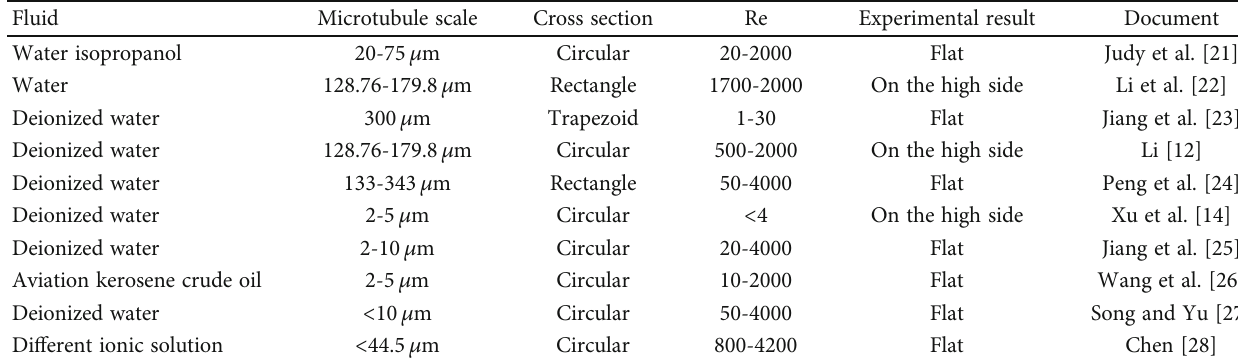
Table 2: Flow experiment deviating from the N-S equation in microcircular